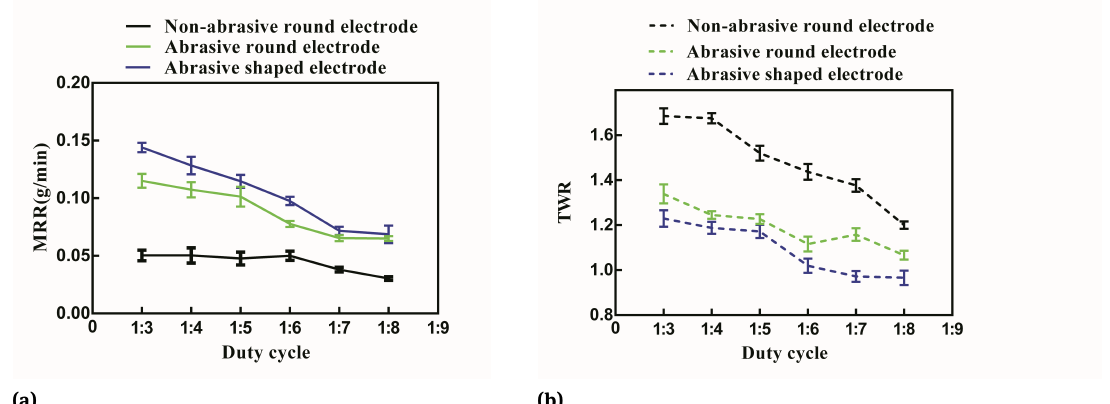
Figure 10: Influence of duty cycle on MRR and TWR (applied voltage = 120V, peak current = 25 A, pulse duration = 120 µ s, rotary speed = 2400